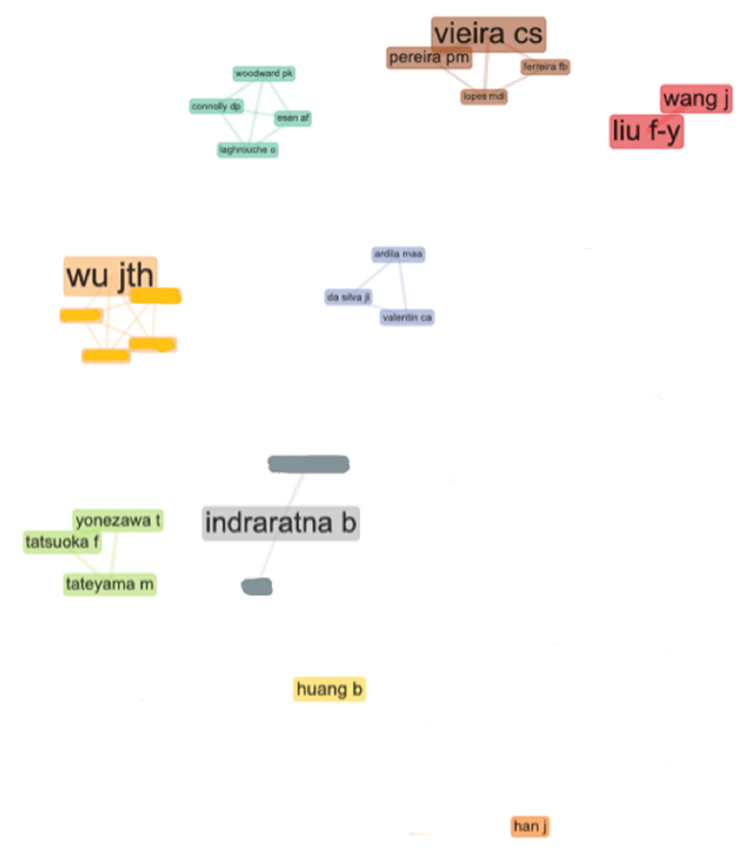
Figure 11. Main authors’ collaboration network.